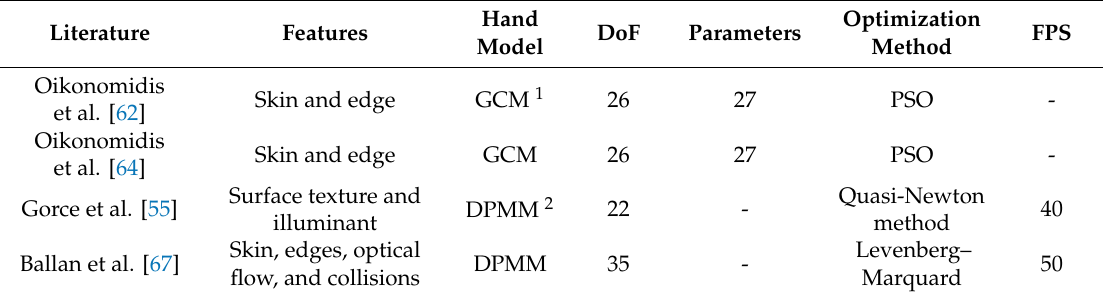
Table 2. Summary of generative methods for hand pose estimation with RGB input.